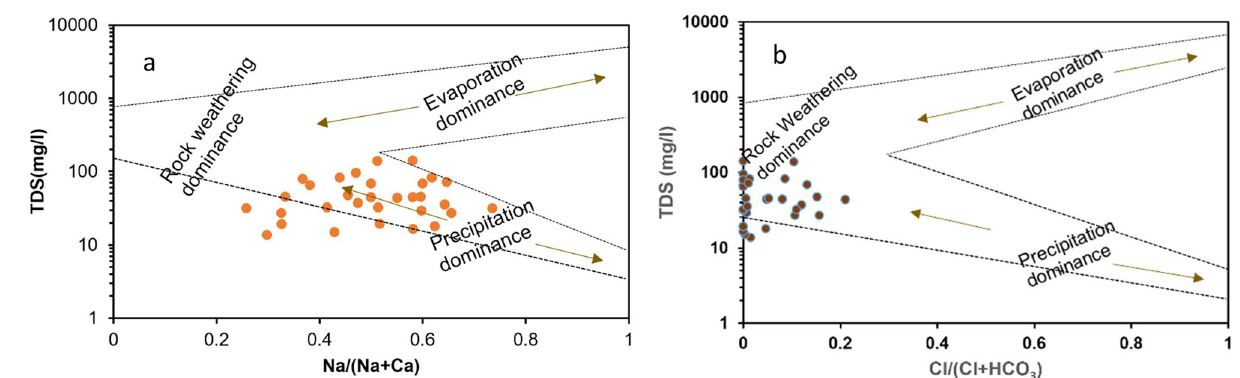
Figure 9. Gibbs diagrams ( a ) cations: TDS vs Na + /Na + + Ca 2+ ) ( b ) anions: TDS vs Cl/(Cl - + HCO 3- )reveals water chemistry controlling